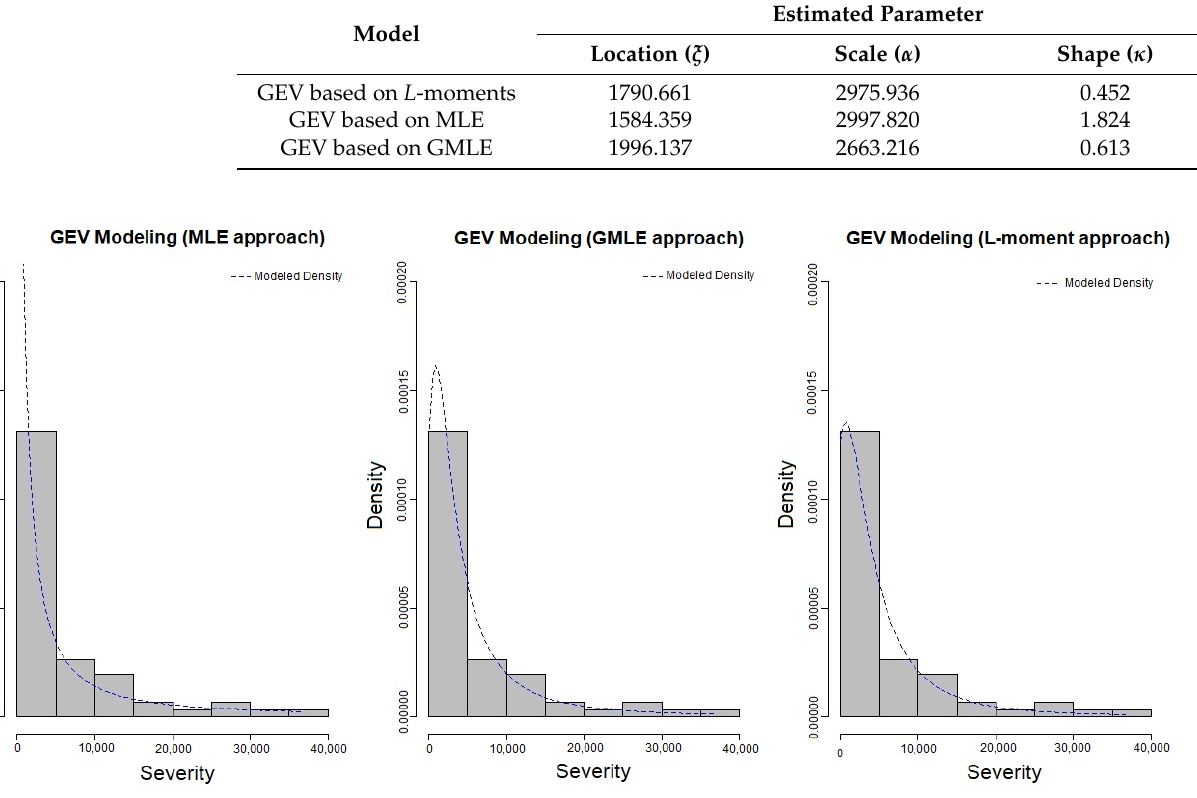
Figure 8. PP ‐ plot on the fitted GEV model based on different estimation approaches.